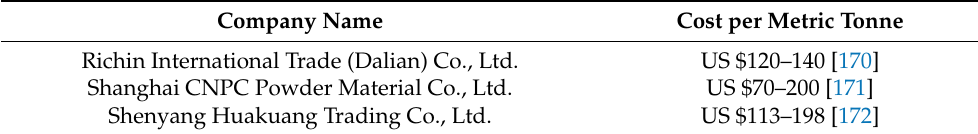
Table 10. Cost of Wollastonite in Various Companies.